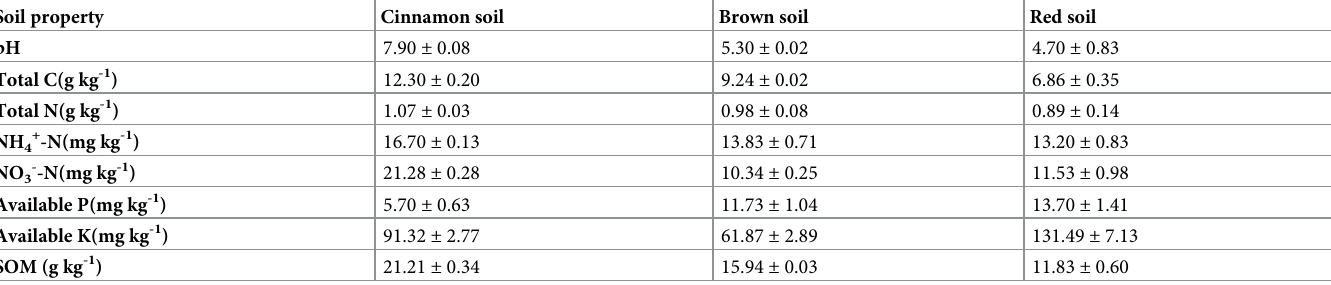
Table 1. Physicochemical properties of the three agricultural soils (0–20 cm soil layers). Soil